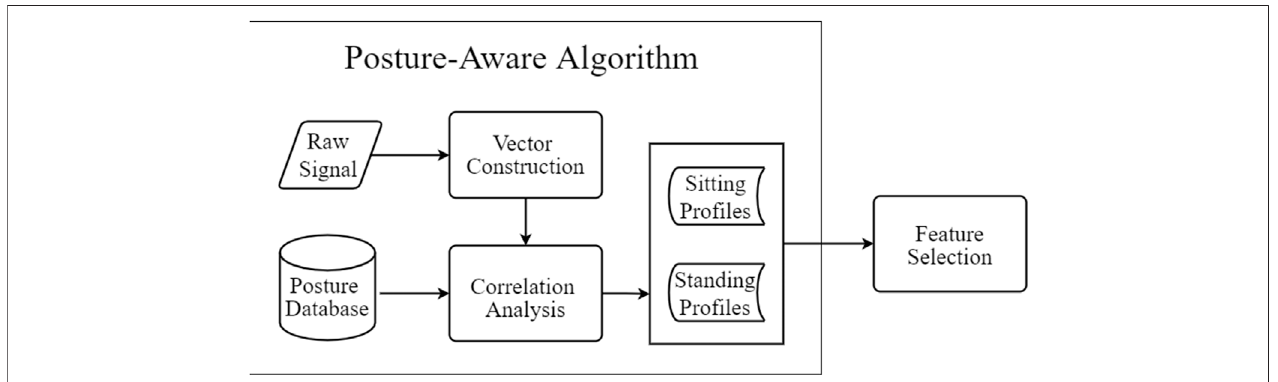
FIGURE 4 | Flowchart of user-independent posture-aware